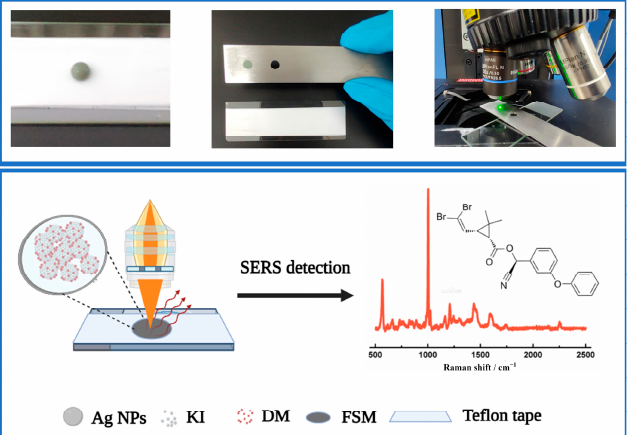
Scheme 1. Schematic representation of the proposed FSM SERS method for DM analysis. The red line in the schem represents the SERS spectra of DM.